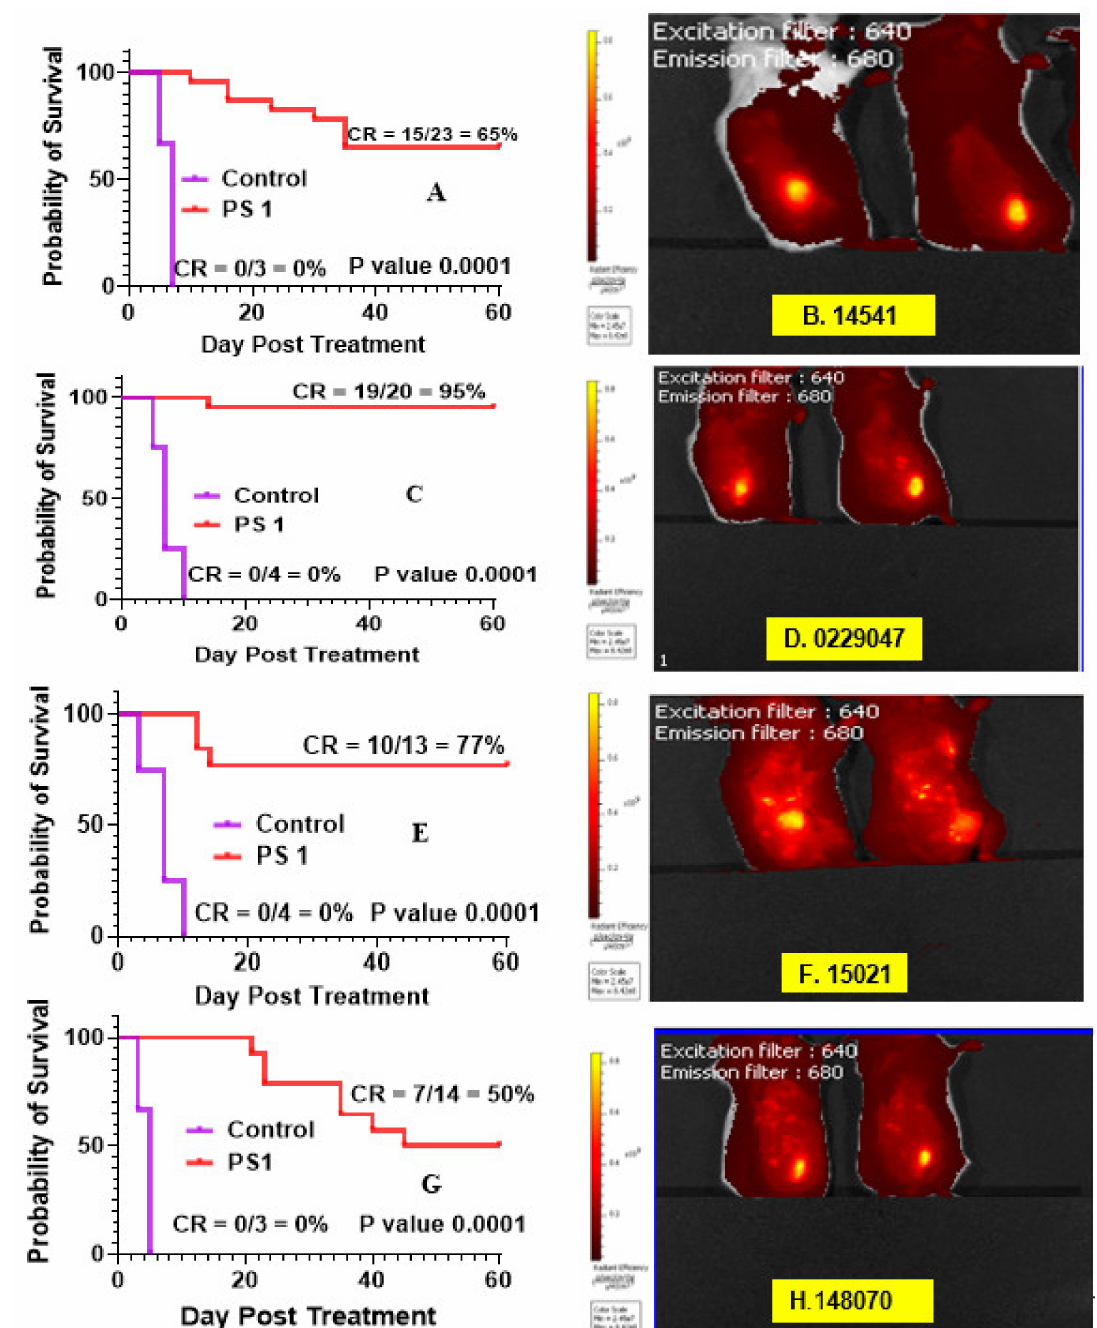
Figure 9. Fluorescence imaging and PDT efficacy of SCID mice bearing PDX lung tumors: ( A ) PDT efficacy of mice bearing SCLC 14541 tumors and ( B ) tumor images; ( C ) PDT efficacy of mice bearing SCLC 2229047 tumors and ( D ) tumor images ; ( E ) PDT efficacy of mice bearing NSCLC 15021 tumors and ( F ) tumor images; ( G ) PDT efficacy of mice bearing NSCLC 148070 tumor and ( H ) tumor images. For determining long-term efficacy, mice were injected (i.v.) with PS 1 (1 mmol/kg), and at 24 h post-injection, the tumors were exposed with light (665 nm, 135 J/cm 2 , 75 mW/cm 2 ), and tumor growth was monitored daily for 60